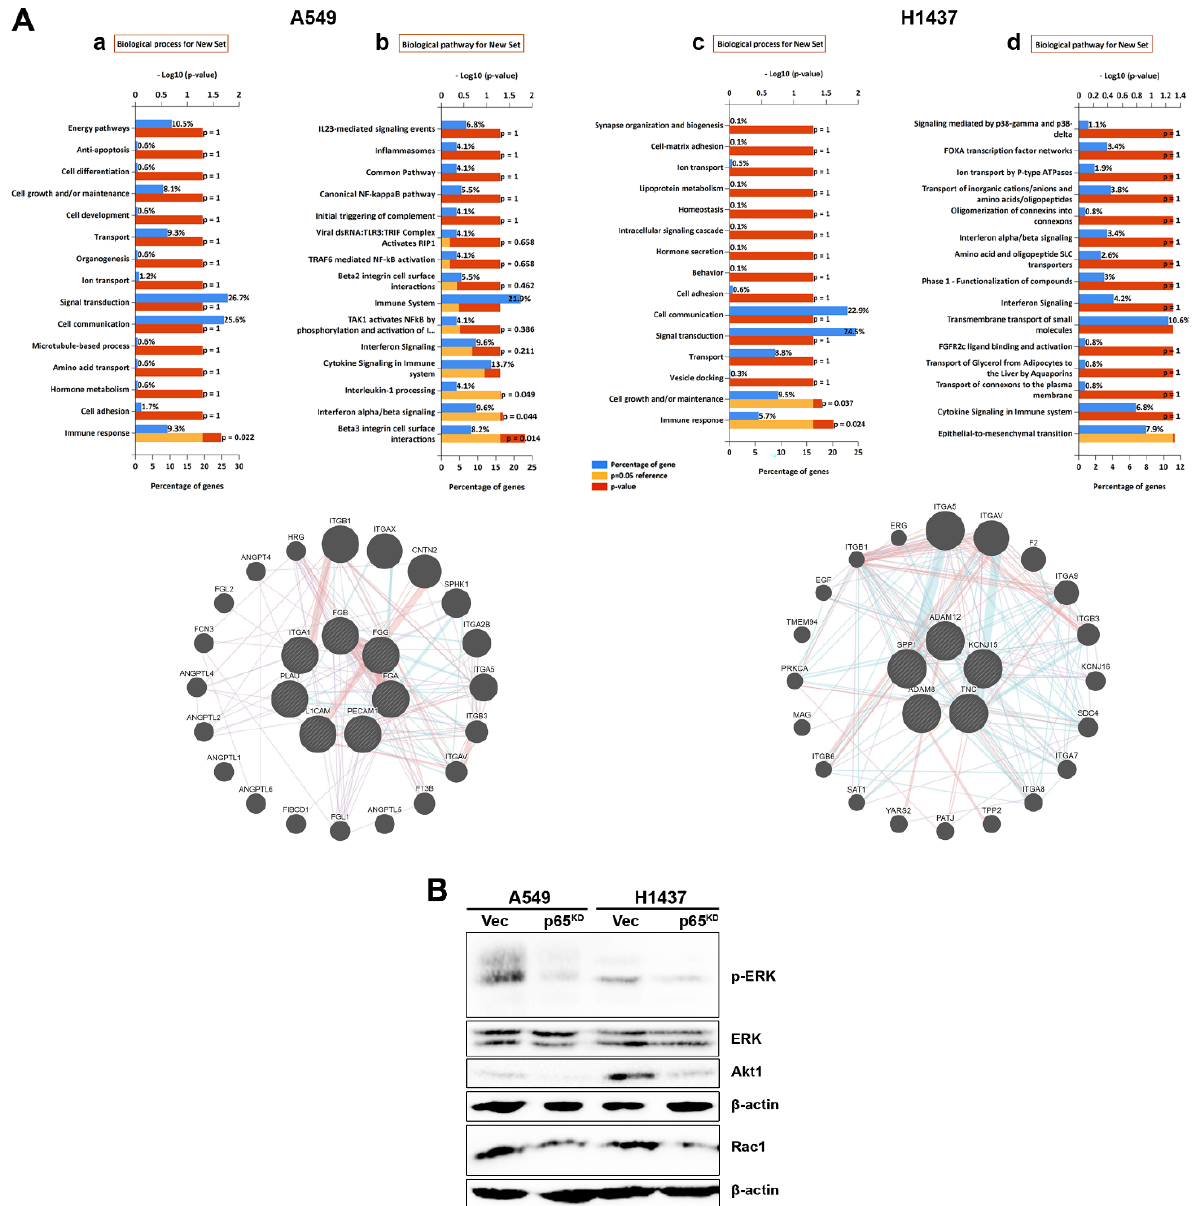
Figure 7. Effects of p65 on integrin-mediated signalling in human lung cancer cells. ( A ) Bioinformatics analysis of NF- κ B RelA/p65-regulated genes involved in a particular pathway. Panels ( a , b ) show the biological processes and the percentage of genes of the entire cohort involved in a particular process. Panels ( c , d ) show the biological pathways affected. The analysis of all genes in the human A549 and H1437 NSCLC cell lines revealed that genes involved in immune response, integrin pathways and epithelial-to-mesenchymal cell transition were affected. The red/yellow bars represent the p -value. The more yellow, the more significant the enrichment. The role of the enrichment is to identify processes that can be potentially altered based on all differentially expressed genes. All genes involved in integrin pathways for A549 and H1437 and for “α 9 β 1 integrin signalling events ” were used to model gene-gene interactions revealing an interesting crosstalk. ( B ) Expression of protein molecules involved in integrin-mediated signalling, such as ERK, phospho-ERK, Akt1 and Rac1 in vector control and p65 KD A549 and H1437 human lung cancer cells.